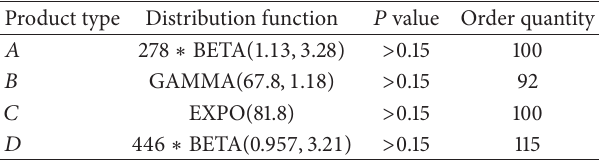
Table 6: Estimation of distribution functions of demand and reor- ders